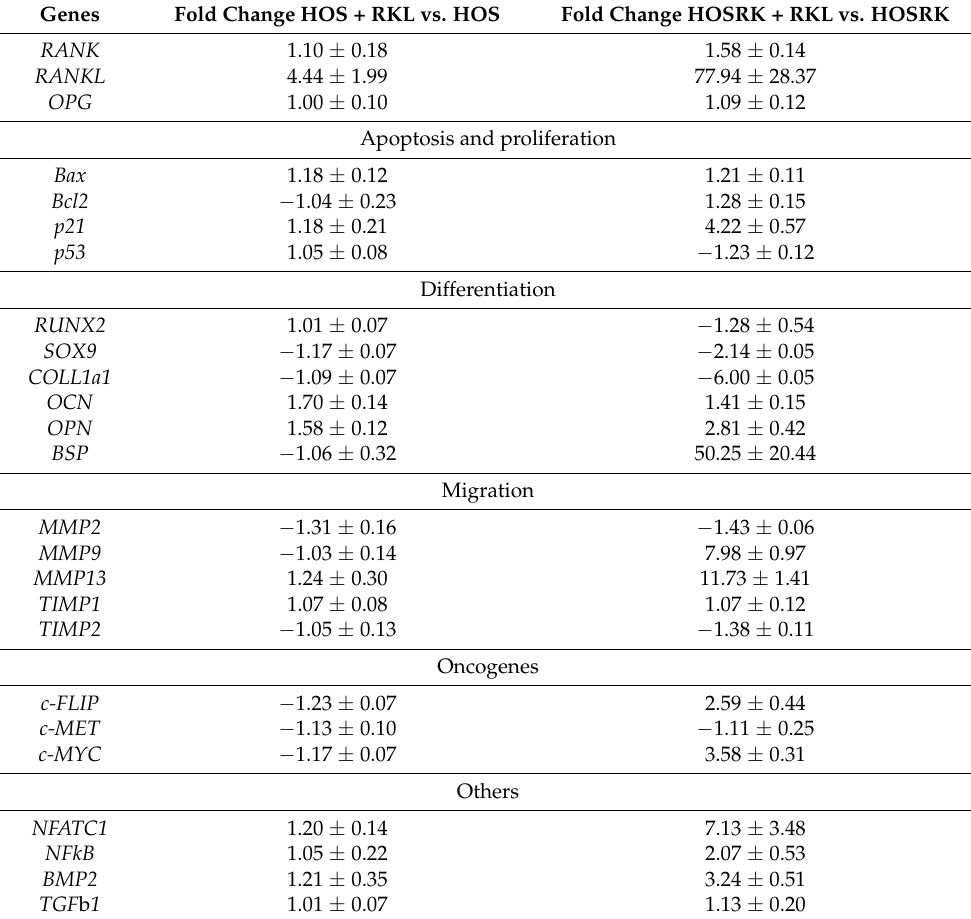
Table 1. RT-qPCR analysis of the impact of adding RANKL to cultures of HOS cells that are native or over-expressing